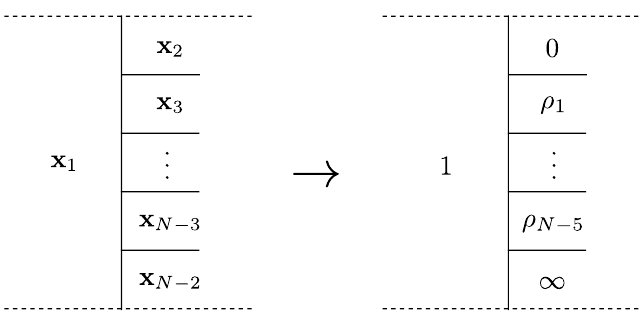
Figure 1 . Simplicial MRK coordinates parametrising the transverse space for the scattering of N particles in